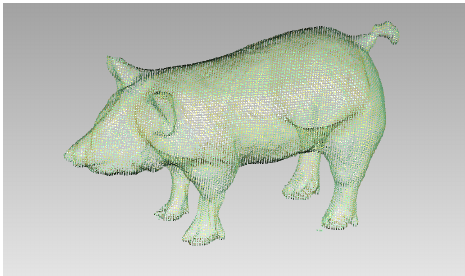
Figure 2. Point cloud data of pig profile.